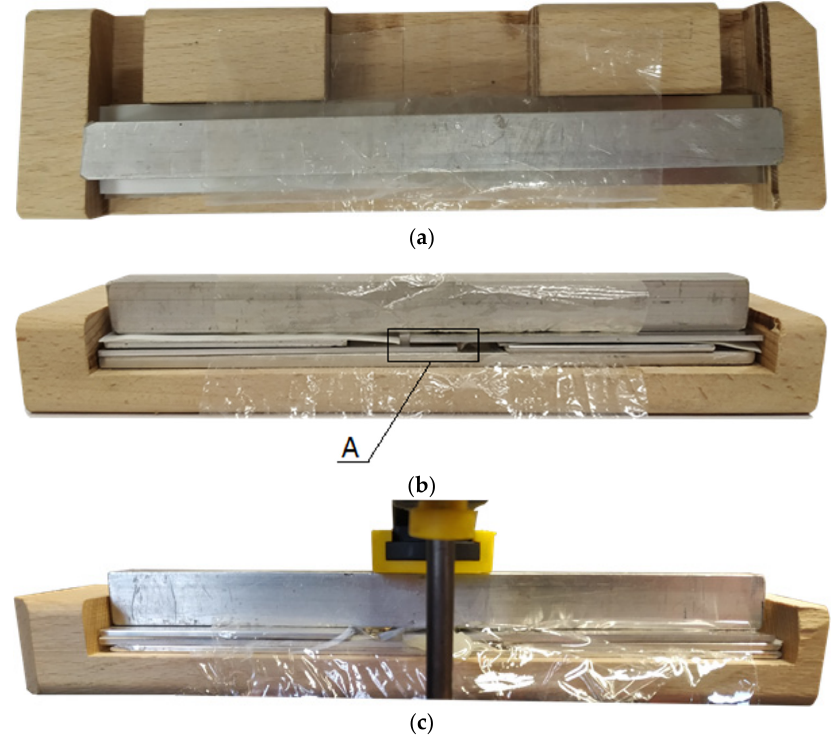
Figure 8. A test stand for adhesion of a single-lap specimen: ( a ) top view, ( b ) front view, ( c ) view of device during the process of the specimen adhesion; A—place for a joint.